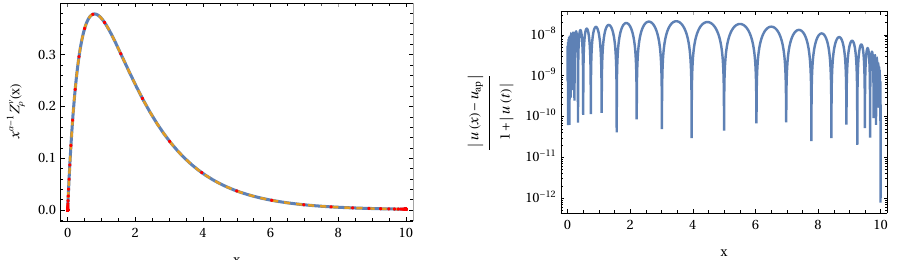
Figure 5. The Krätzel function used as a probability density function for ρ = 3, ν = 2, and α = 2 (left panel). The relative local error of the distribution f ( x ) = x α − 1 Z ν ρ ( x ) (right panel). Number of Sinc points N =